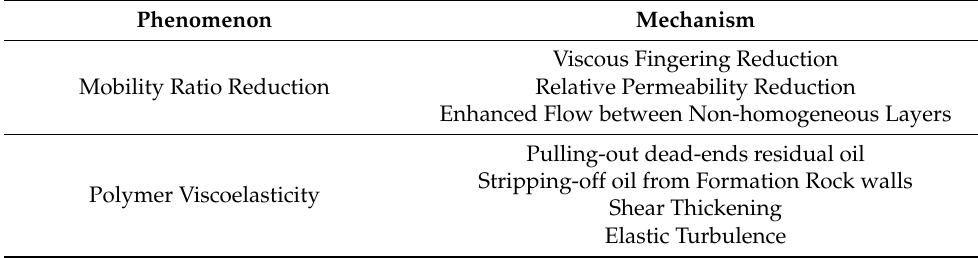
Table 1. Overview of the mechanisms reported to enhance oil recovery due to polymer